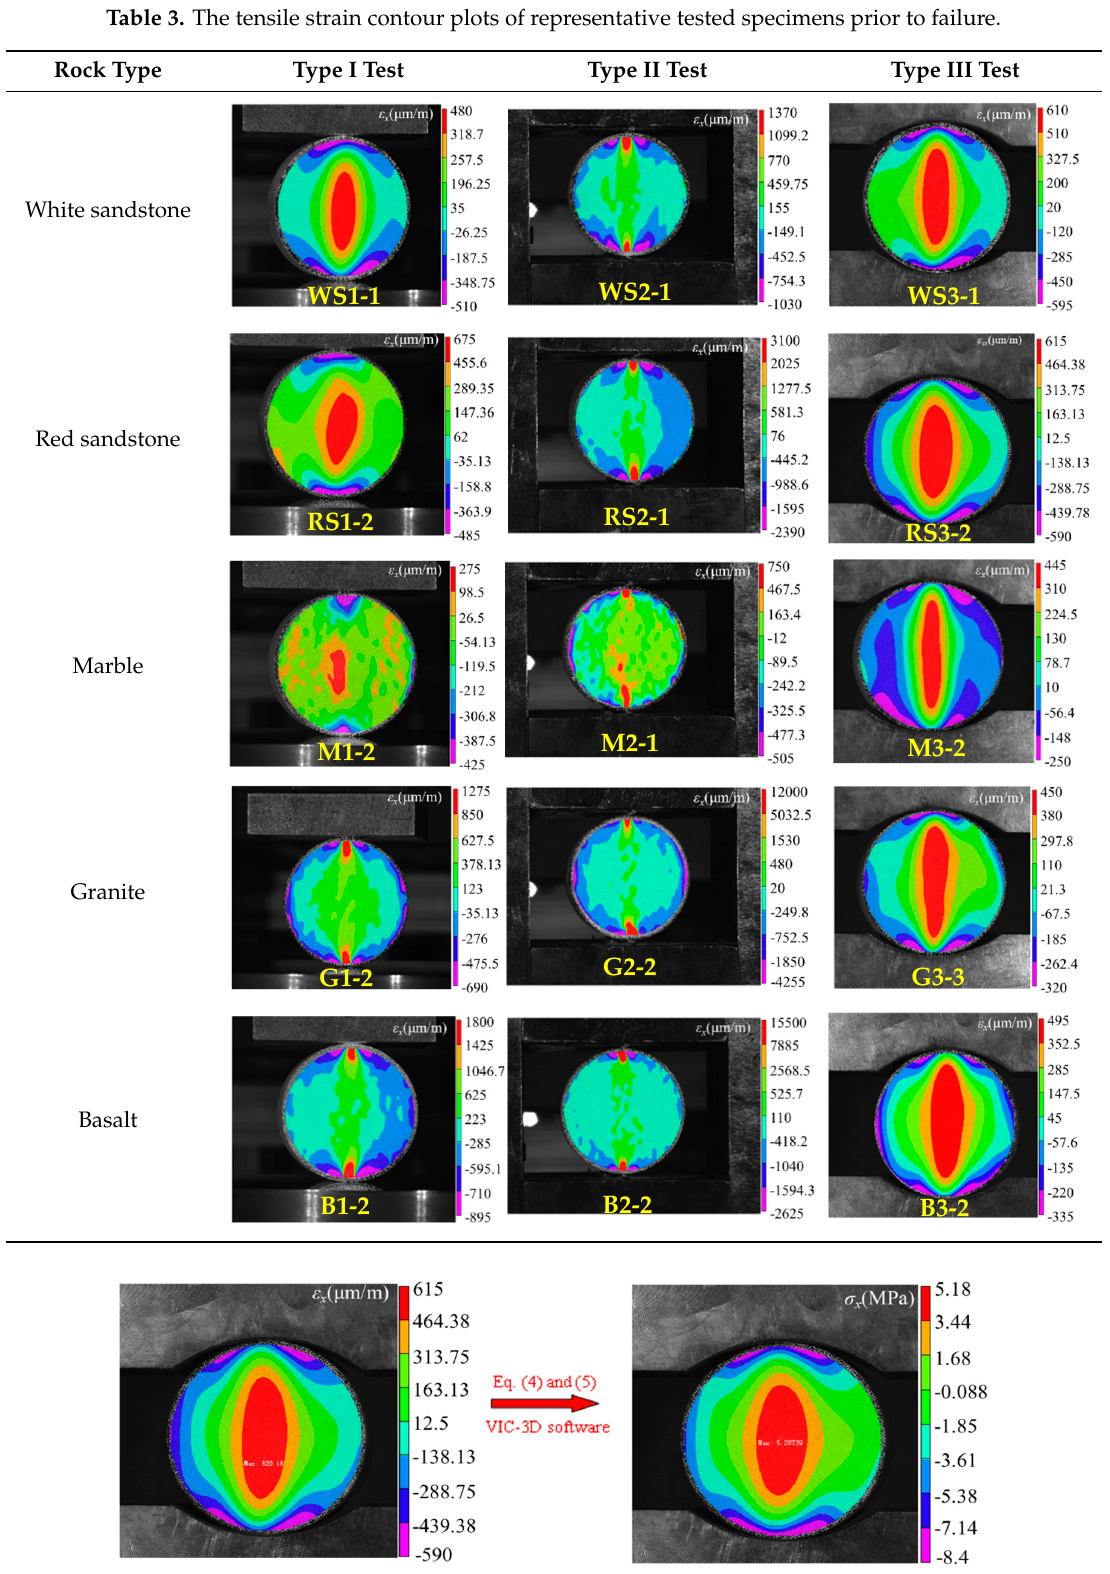
Figure 5. Transition of strain and stress contour diagram of specimen RS3-2.